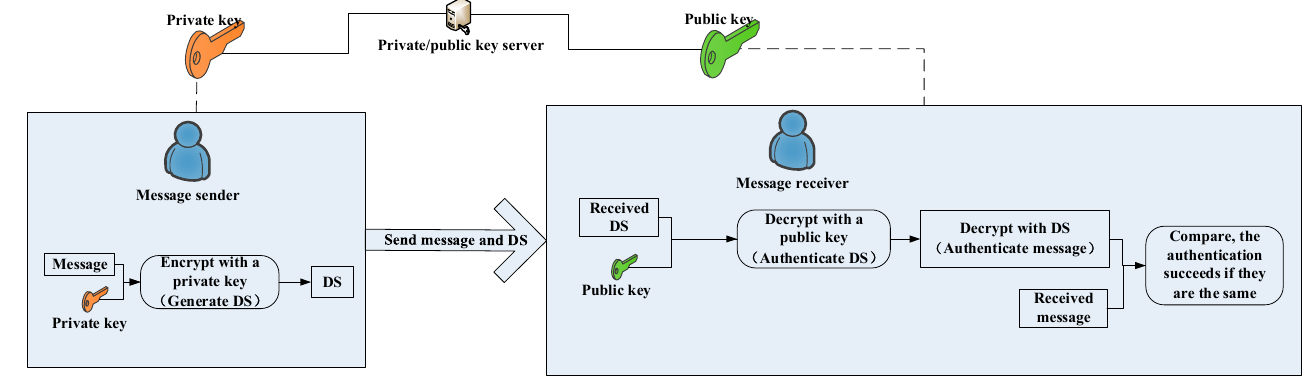
Figure 4. Digital Signature Schematic.